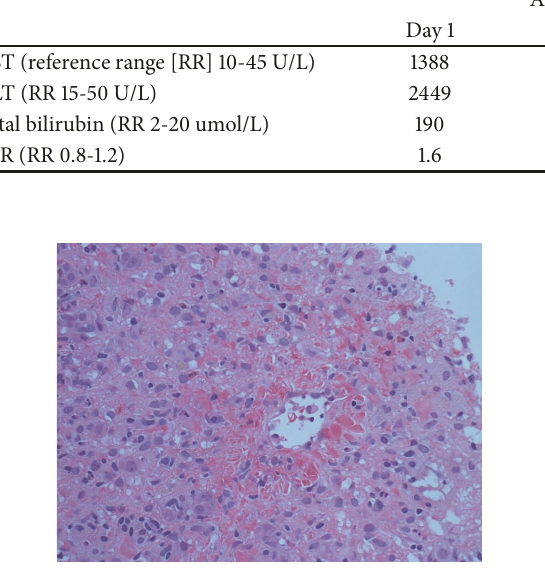
Figure 1: Haematoxylin and eosin stain at 400x magnification demonstrating numerous apoptotic bodies and patchy fibrotic changes in the perivenular and portal areas. This is consistent with generalized cholestatic and inflammatory changes.